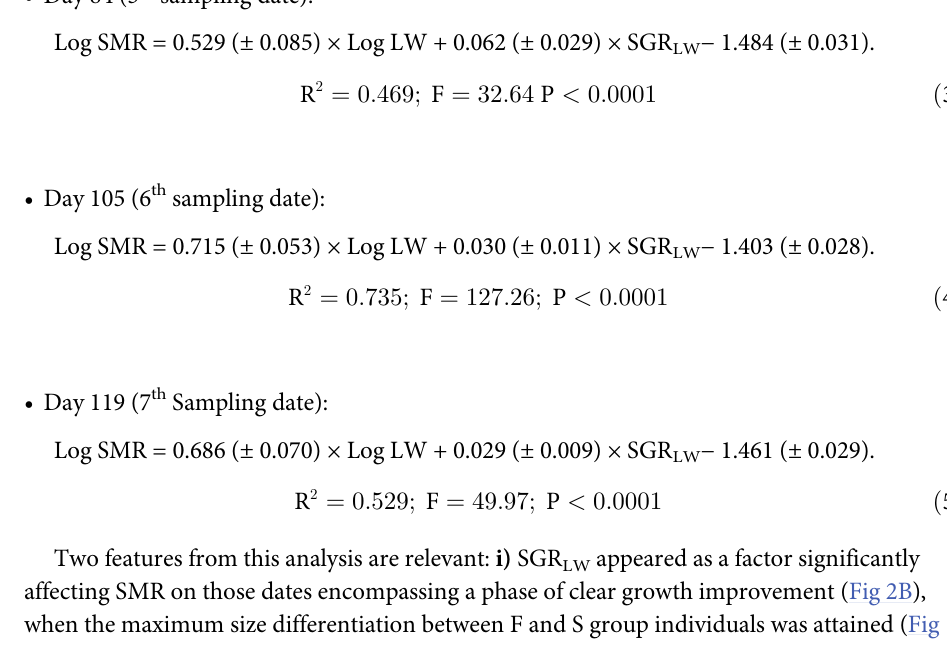
revealed significant differences between slopes b of regression lines (Table 2), and the mean comparison (Tukey’s test) indicated significantly higher mass exponent on day 21 ( b = 1.05) than of most of the sampling points (4 th , 5 th , 7 th , and 8 th sampling dates). ANCOVA compari- sons following the removal of this day 2 equation showed no significant differences between